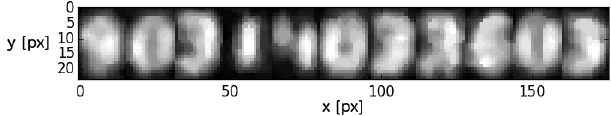
Figure 14. The extracted and normalised digits of image B (Fig. 5). Prediction: 90 314 03 36.